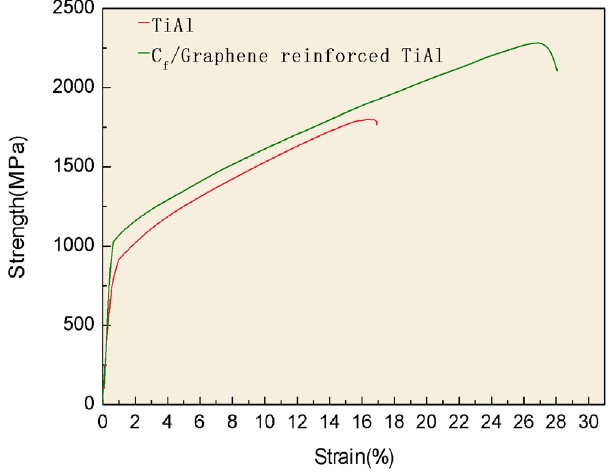
Figure 5. The compression curves of pure TiAl and final CFGRTAC.